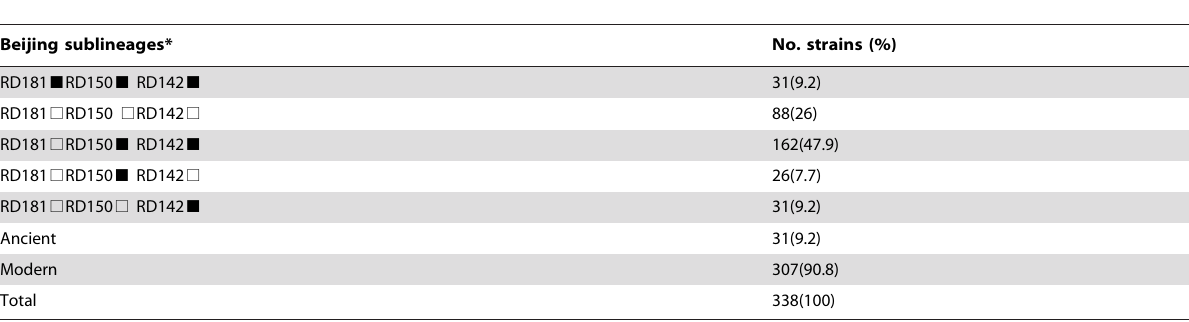
Table 1. RD typing of Beijing lineages of Mycobacterium tuberculosis .